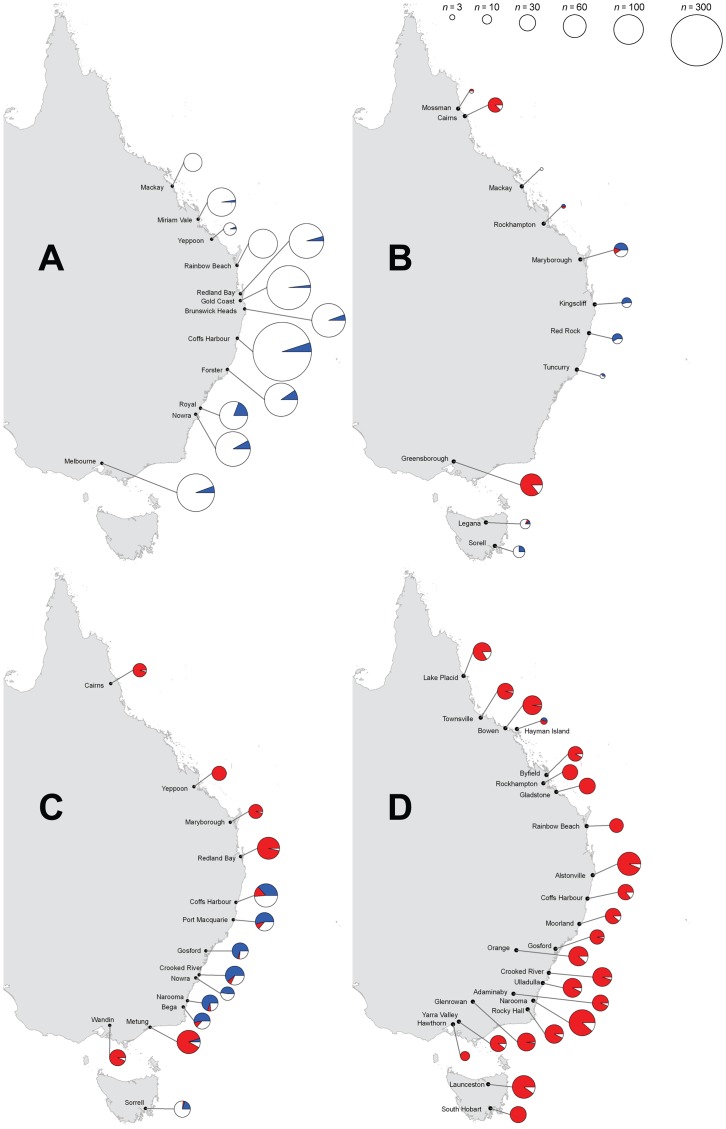
Location of Drosophila simulans collection sites in eastern Australia and the frequency of infection by wAu and wRi in (A) 1994 (data adapted from Hoffmann et al. [33]), (B) 2004, (C) 2008 and (D) 2011/12.Blue shaded parts of the pie are wAu-infected D. simulans, red shaded are wRi-infected and unshaded are uninfected individuals. Pie size represents sample size (n).